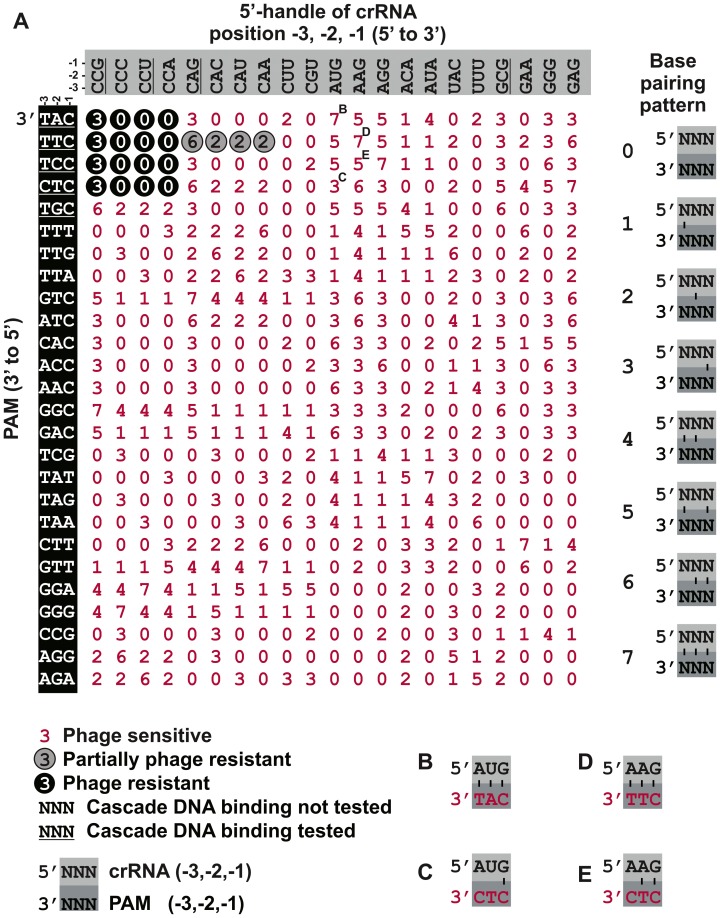
Synonymous mutations of the crRNA and the PAM do not affect self versus non-self discrimination.
A) Infectivity of a library of M13 phage containing PAM mutants adjacent to the g8 protospacer was tested against cells expressing Cascade, Cas3 and g8 CRISPR containing mutations at the −1, −2 and −3 nucleotides of the CRISPR repeats. PAM mutations are shown on the left, with the PAM sequences indicated in the 3′ to 5′ direction. CRISPR repeat mutations at positions −1, −2 and −3 are indicated on the top in the 5′ to 3′ direction. Underscored sequences have been tested for binding affinity by EMSA. Base pairing potential between the PAM positions and the repeat is indicated using numbers (0–7) that correspond to a base pairing pattern that is shown in the panel on the right. A 0 signifies no base pairing, a 1 signifies base pairing at the −3 position, a 2 signifies base pairing at the −2 position, etc. Black circles with white digits indicate resistance against phage infection (e.o.p.<10−4), grey circles indicate partial resistance (e.o.p.∼10−2) and red digits without circle indicate susceptibility to phage infection (e.o.p. = 1), as determined by phage spot assays. Letters B, C, D, E indicate combinations shown in detail in the corresponding panels. B) Combination of g8C-3AC-2T CRISPR and M13 phage with CAT PAM, gives rise to full base pairing and a lack of resistance (red font). C) Combination of g8C-3AC-2T CRISPR and M13 phage with CTC PAM, gives rise to only base pairing at the −1 position and yields a lack of resistance (red font). D) Combination of g8C-3AC-2A CRISPR and M13 phage with CTT PAM gives rise to full base pairing and a lack of resistance (red font). E) Combination of g8C-3AC-2A CRISPR and M13 phage with CTC PAM gives rise to only two potential base pairs at the −1 and −2 positions and yields a lack of resistance (red font). Note in (A–E) PAMs are oriented in 3′ to 5′direction to display base pairing potential with the last three nucleotides of the crRNA repeat.